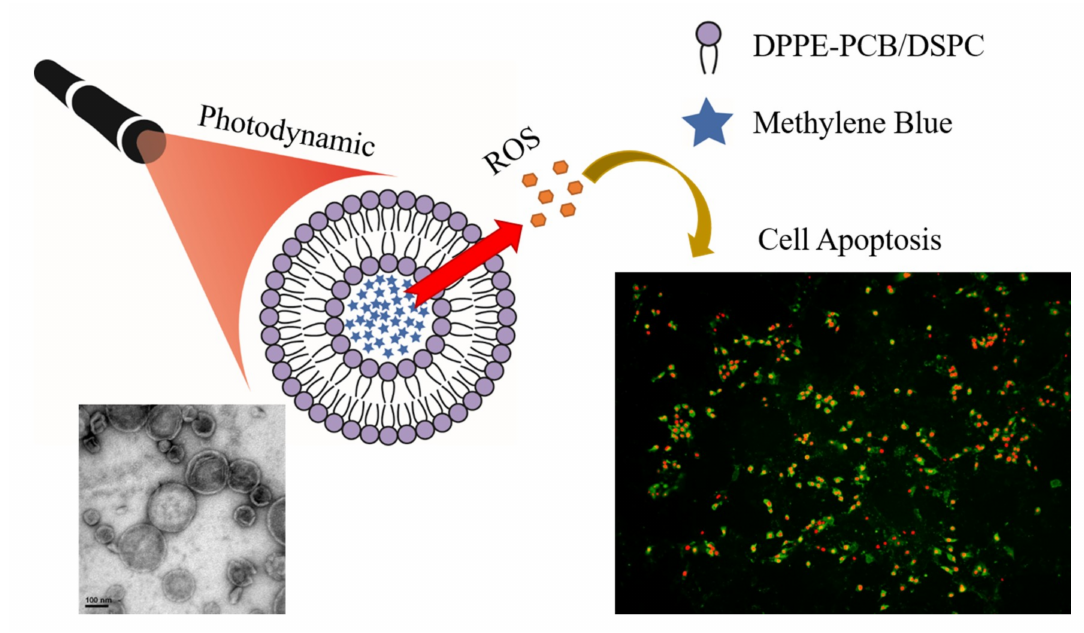
Figure 1. Scheme of the